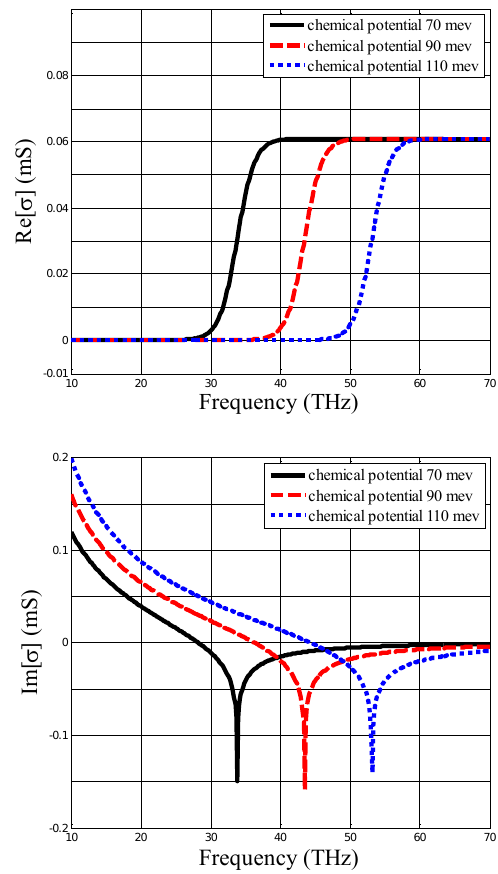
Figure 1: The real and imaginary parts of graphene conductivity versus frequency. The top picture is real part and the bottom picture represent the imaginary part for three value of chemical potential.